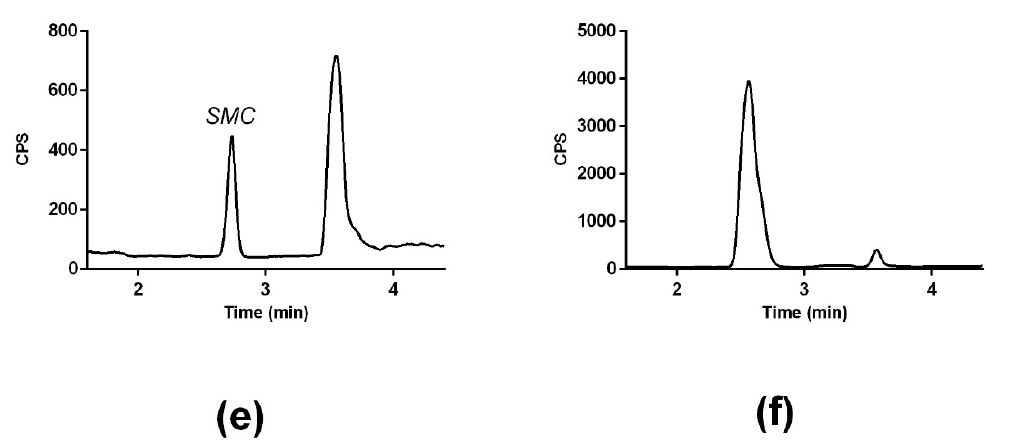
Figure 3. LC-MS / MS chromatograms of SMC and SMCSO in human plasma. ( a ) SMC authentic standard spiked in human plasma; ( b ) SMCSO authentic standard spiked in human plasma; ( c ) SMC detected in human plasma; ( d ) SMCSO detected in human plasma; ( e ) 34 S -d 3 SMC internal standard in plasma; ( f ) 34 S -d 3 SMCSO internal standard in plasma.